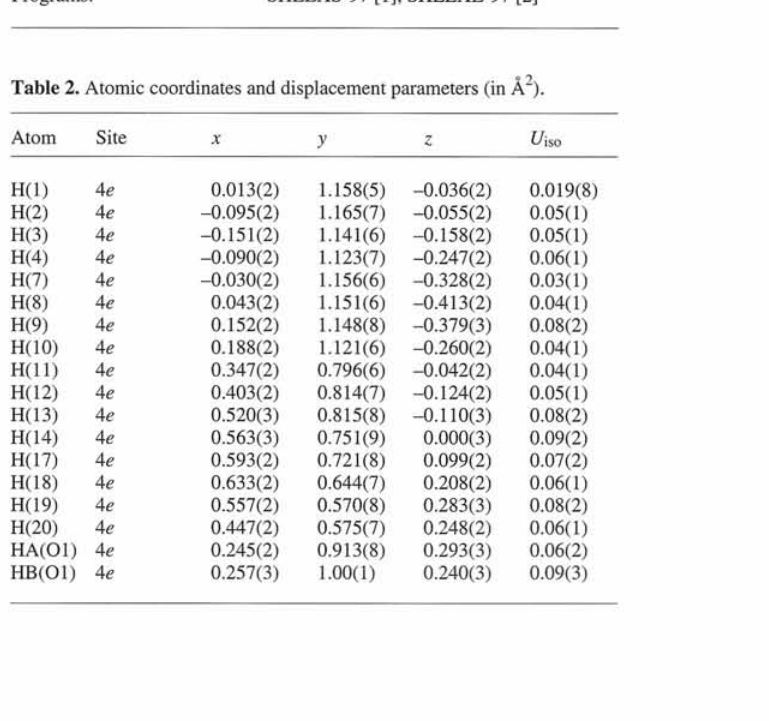
Table 2. Atomic coordinates and displacement parameters (in